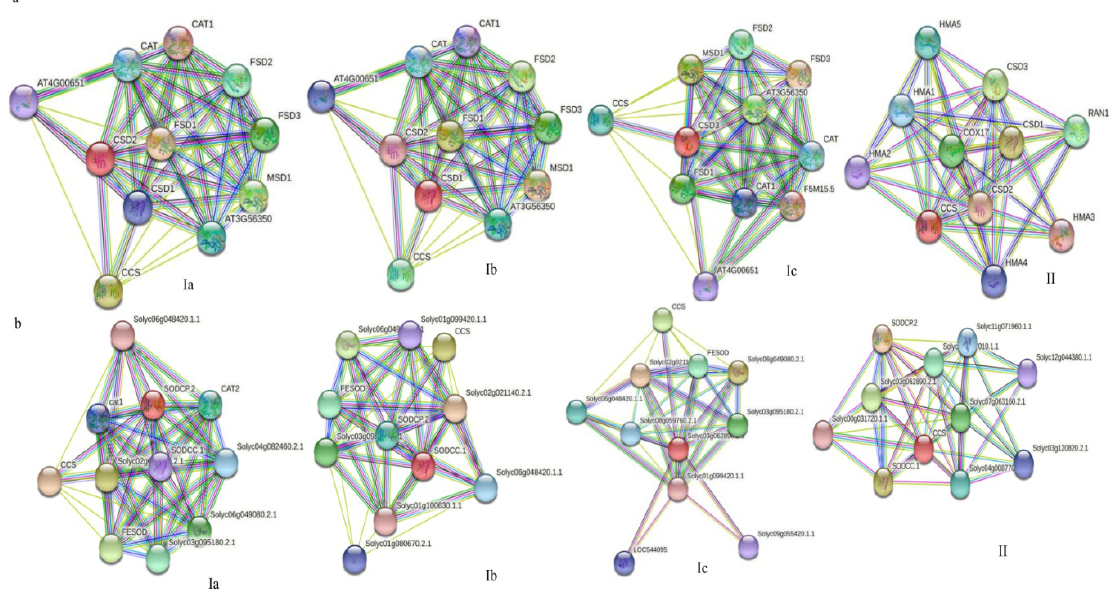
Figure 5. Potential protein–protein interaction network of plant Cu/ZnSODs. ( a ) Arabidopsis thaliana. ( b ) Solanum lycopersicum. The higher the interaction coefficient, the thicker the line between proteins is, and vice versa.